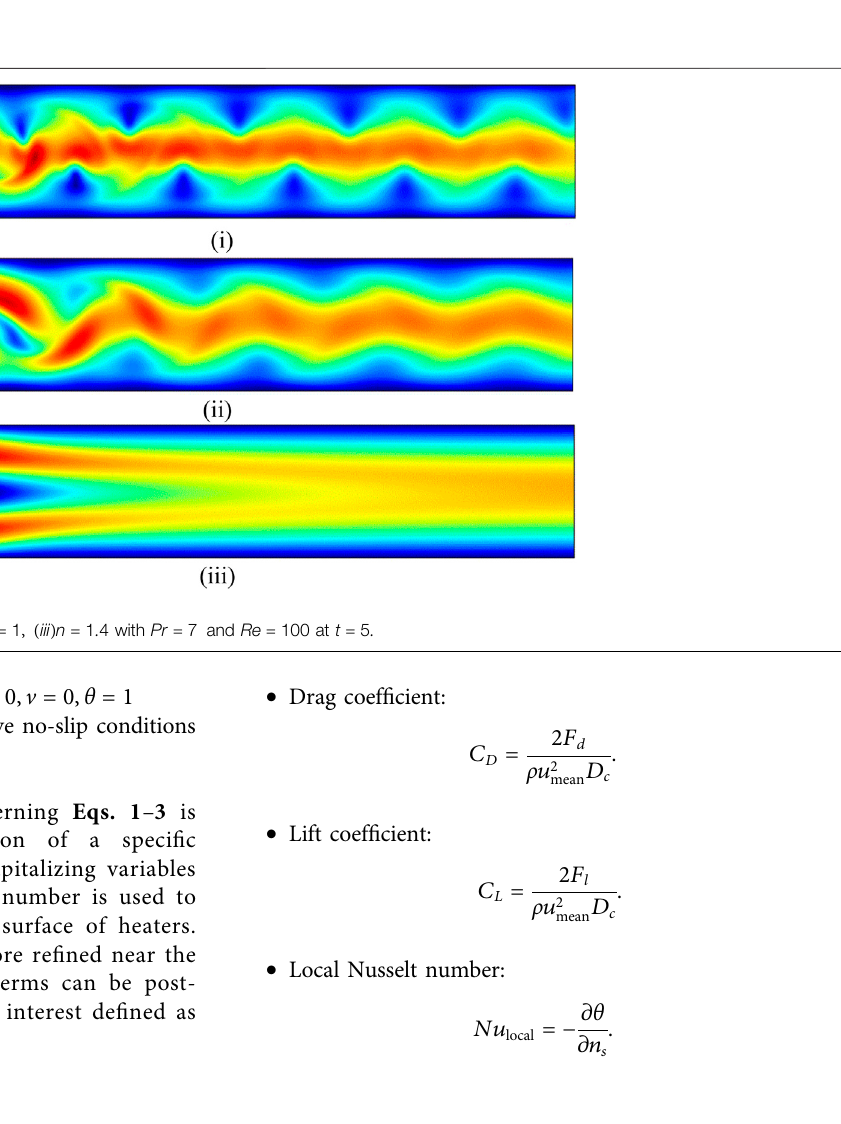
Frontiers in Physics |